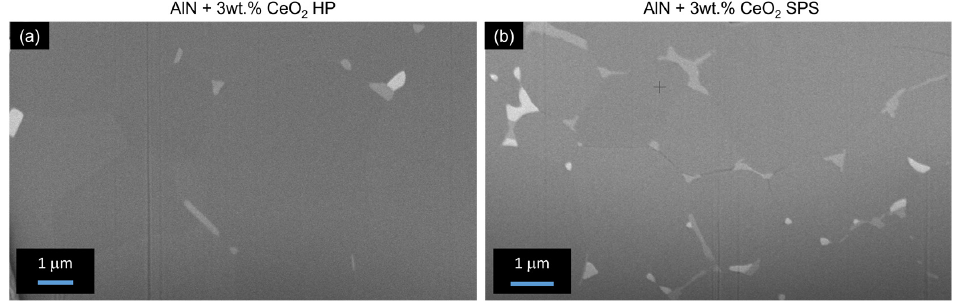
Figure 9. Microstructure of AlN + 3wt.% CeO 2 samples polished in situ by SEM-FIB. ( a ) sample sintered by HP, ( b ) sample sintered by SPS.